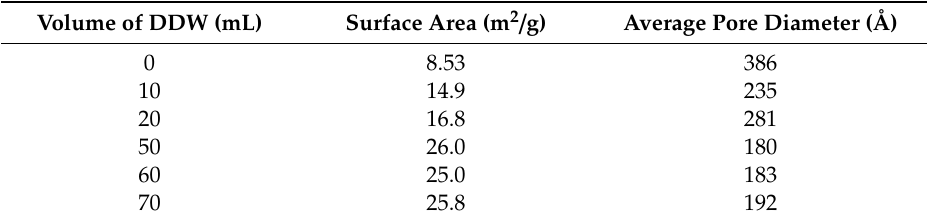
Figure 2. FESEM images of CaCO 3 at di ff erent volumes of distilled water: ( a ) 0 mL; ( b ) 10 mL; ( c ) 20 mL; ( d ) 50 mL; ( e ) 60 mL; and ( f ) 70 mL. Table 1. Brunauer–Emmett–Teller (BET) average surface area, pore diameter of CaCO 3 in di ff erent volumes of double-distilled water